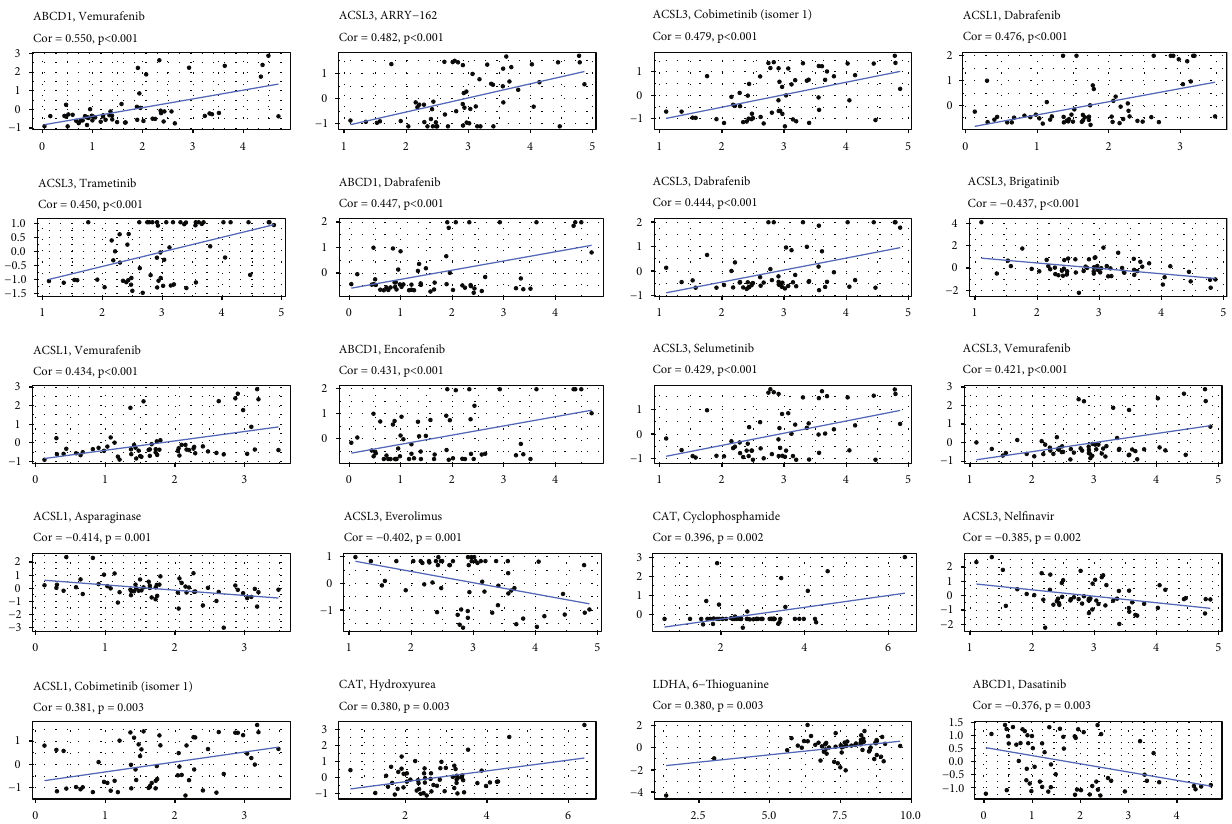
Figure 7: The relationship between expression of signature genes and